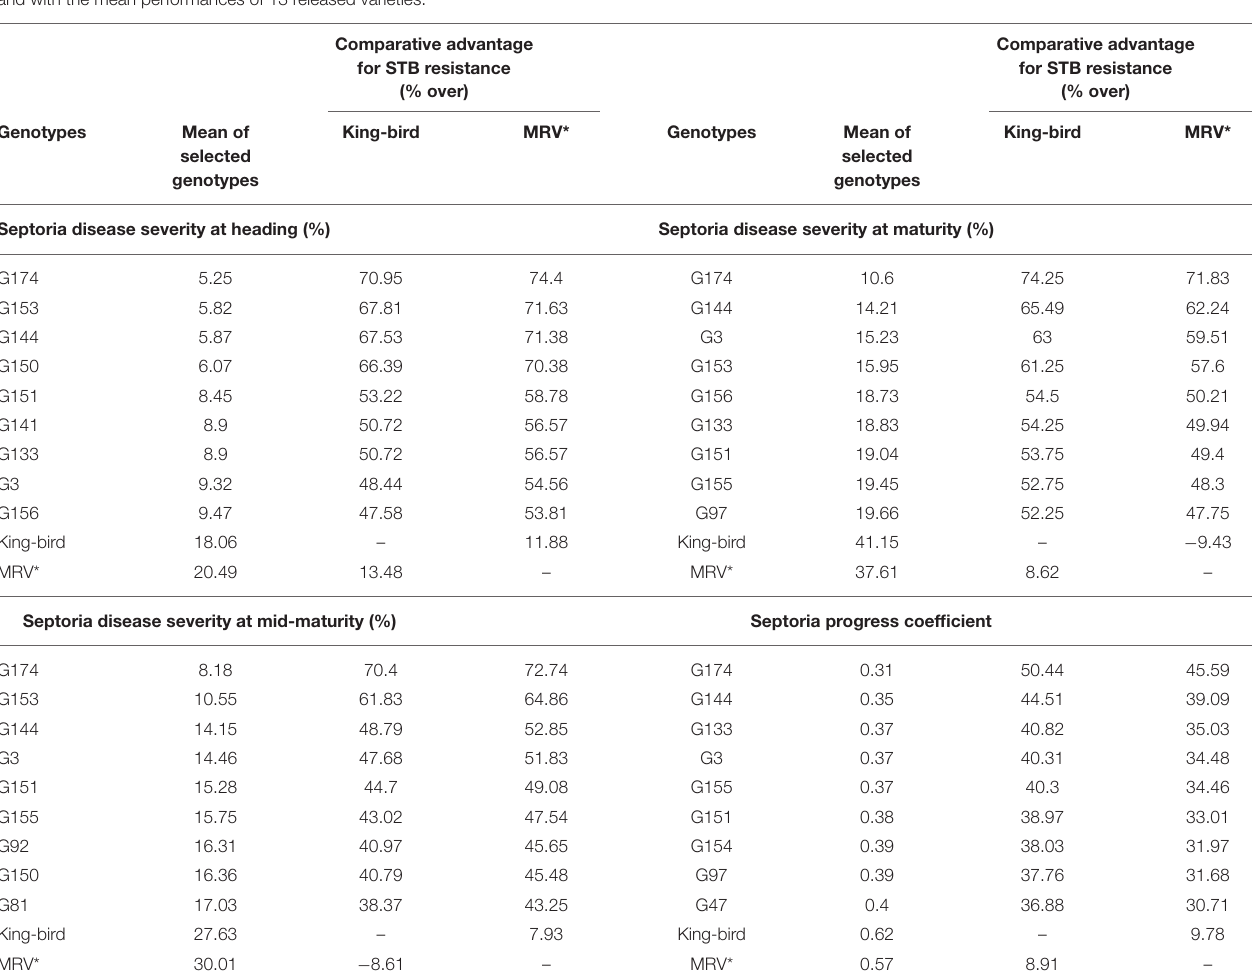
TABLE 5 | Comparison of the mean performances of 5% of the genotypes selected for Septoria tritici blotch (STB) resistance with King-bird, a recently released variety, and with the mean performances of 13 released varieties.